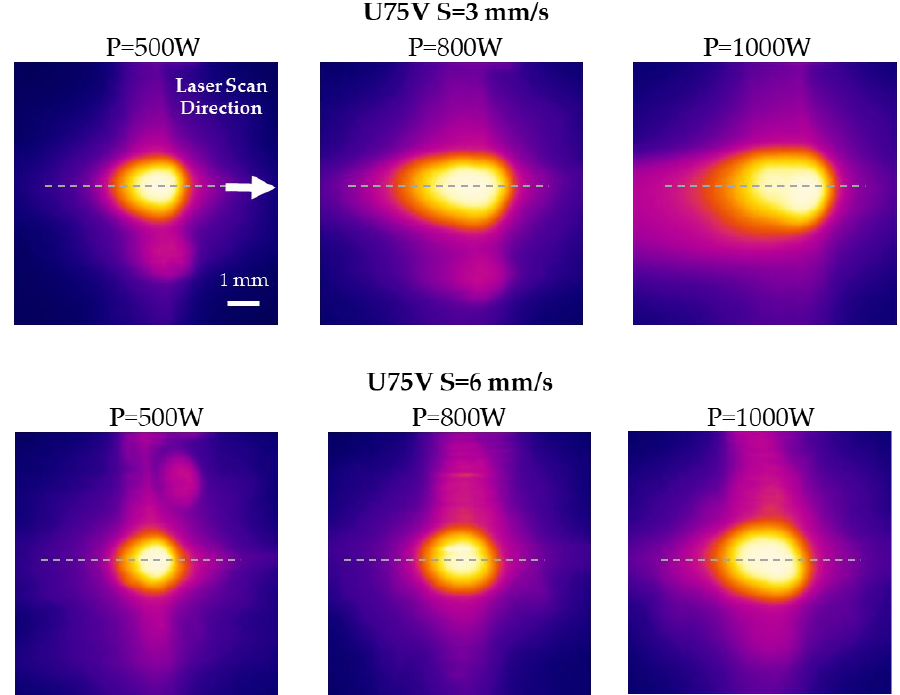
Figure 8. Laser hot-spot profiles during laser cladding on U75V substrate for different laser powers and scanning speeds.